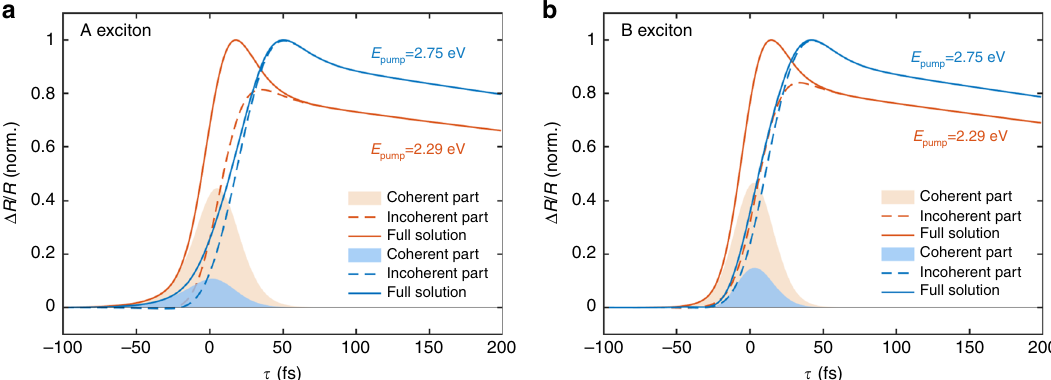
Fig. 4 Coherent and incoherent exciton dynamics. a Calculated Δ R/R dynamics at the energy of the A 1 s resonance considering only the coherent exciton contribution (shaded areas), only the incoherent exciton contribution (dashed lines) and both the contributions (continuous lines) for low (orange traces) and high (blue traces) pump photon energy, i.e., 2.29 and 2.75 eV, respectively. b The same for the dynamics at the energy of the B 1 s